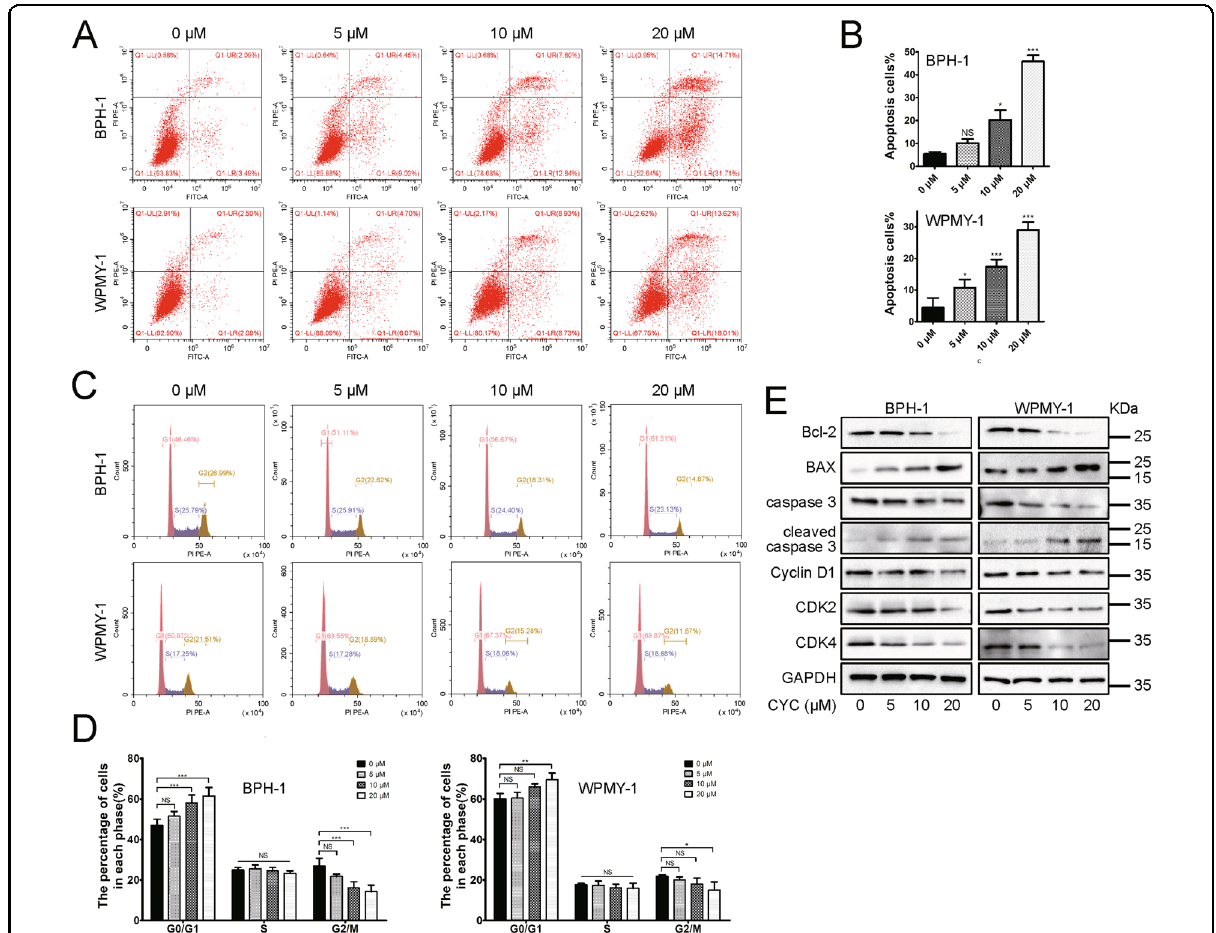
Fig. 4 Downregulation of SMO induces cell apoptosis and cell cycle arrest. A Flow cytometry analysis of the cell apoptosis in BPH-1 and WPMY- 1 after CYC treated for 48 h. PI PE-A in y -axis stands for the fl uorescence intensity of propidine iodide (PI) and FITC-A in x -axis stands for the fl uorescence intensity of fl uorescein isothiocyanate (FITC)-labeled Annexin V. Calculation area of the apoptosis rate was the percentage of Annexin V + /PI + cells. B Statistical analysis reveals the apoptotic rate (%) of BPH-1 and WPMY-1 after CYC treated. C Flow cytometry analysis of the cell cycle in BPH-1 and WPMY-1 after CYC treated for 48 h. Percentages (%) of cell populations at different stages of cell cycles were listed within the panels. D Statistical analysis of the percentages (%) of cell populations at different stages of the cell cycles in BPH-1 and WPMY-1 after CYC treated. E Immunoblot assay of apoptosis-related and cell cycle-related protein in BPH-1 and WPMY-1 after CYC treated. NS means no signi fi cant difference, * p < 0.05, ** p < 0.01, *** p < 0.001; one-way